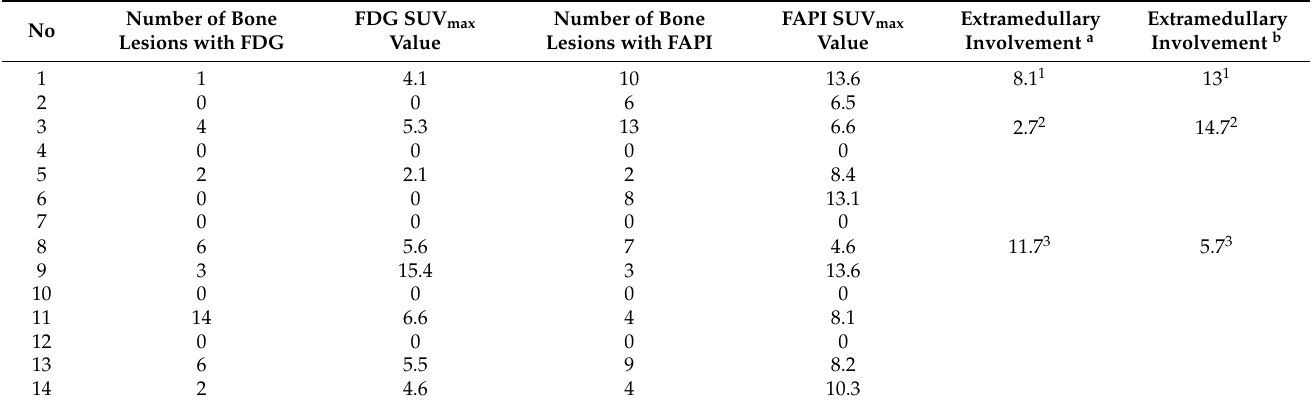
Table 2. Number and SUV max values of lesions detected by [18F]FDG PET/CT and [68Ga]FAPI PET/CT in bone and extramedullary